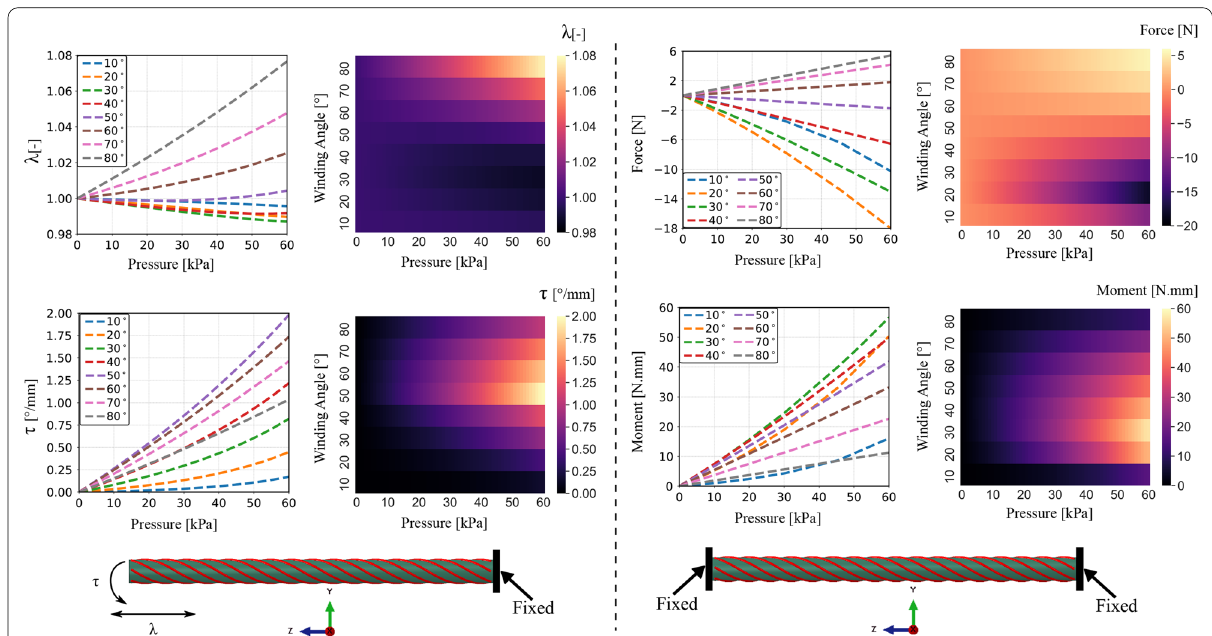
Fig. 8 Parametric studies of FREEs for fiber angles over the range of 10 ◦ to 80 ◦ showing extension per unit length ( (cid:31) z ), rotation per unit length ( τ ), force, and moment as a function of applied pressure (top). Two different boundary conditions were applied to the FREE in each analysis (bottom). In all cases tested, FREEs are modeled with a length of 175 mm, an inner diameter of 9.52 mm, a wall thickness of 0.8 mm, and are wound with six fibers